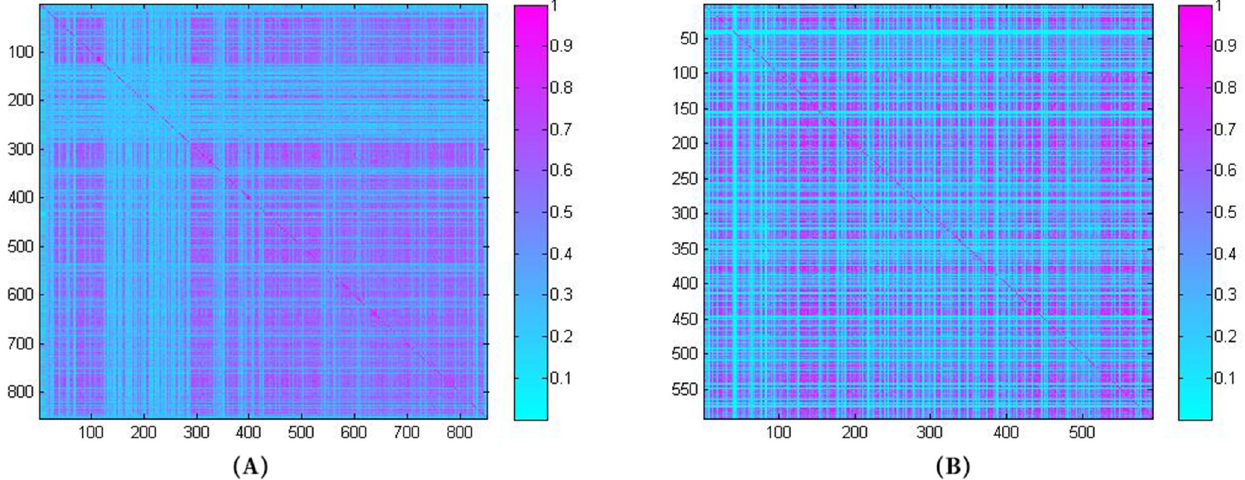
Fig 1. Visualization of (A) miRNA similarity matrix, (B) disease similarity matrix.